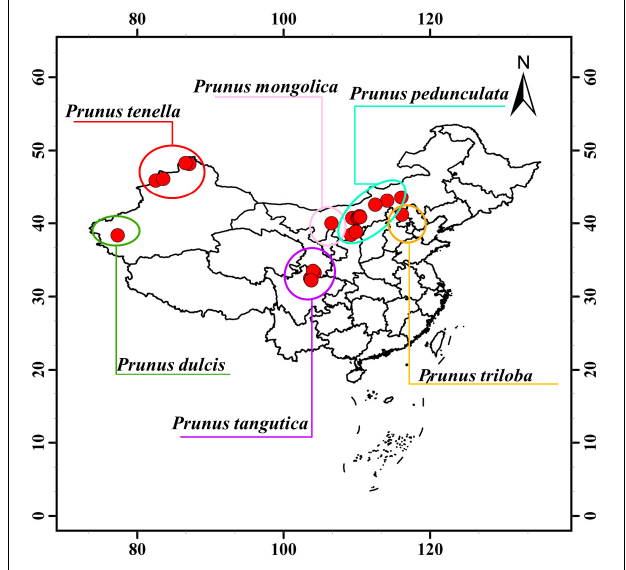
FIGURE 1 | Geographic distribution of different sampled positions of Prunus spp.